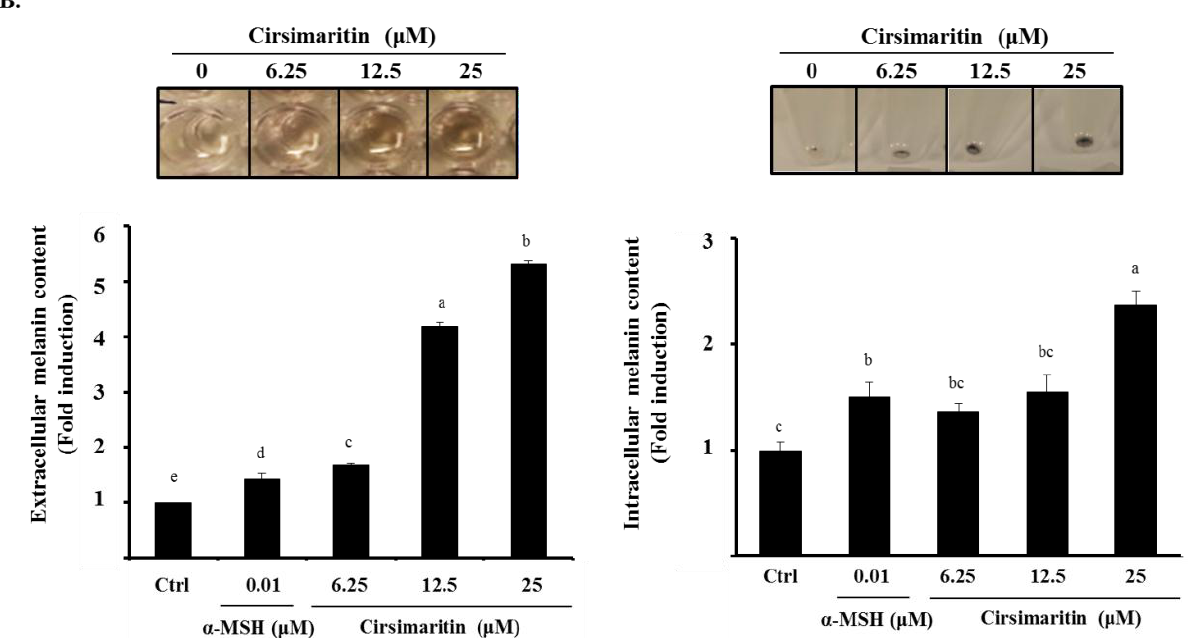
Figure 2. Effects of cirsimaritin on melanogenesis in B16F10 cells. Cells were treated with 0.1% ( v / v ) DMSO, α-MSH (0.01 μM), or cirsimaritin (6.25, 12.5, or 25 μM) for 24 ( A )